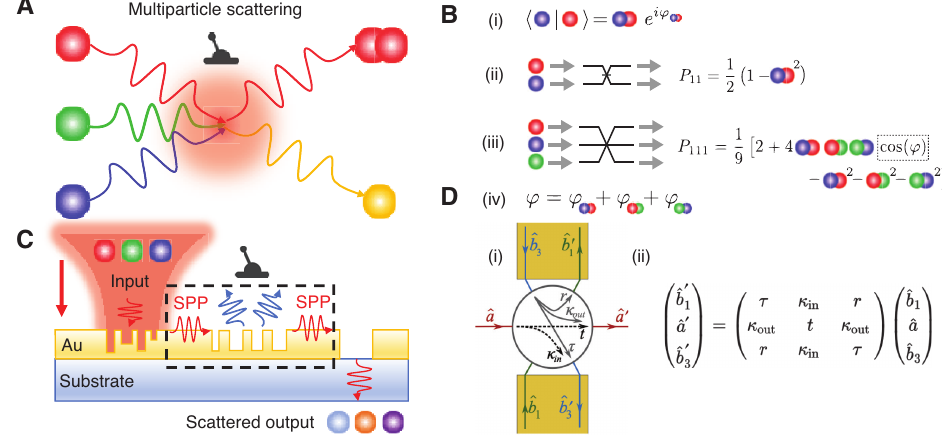
Figure 6: Multiparticle scattering in hybrid photonic-plasmonic systems. (A) Concept behind the control of multiphoton dynamics through the manipulation of electromagnetic near-fields. Interestingly,